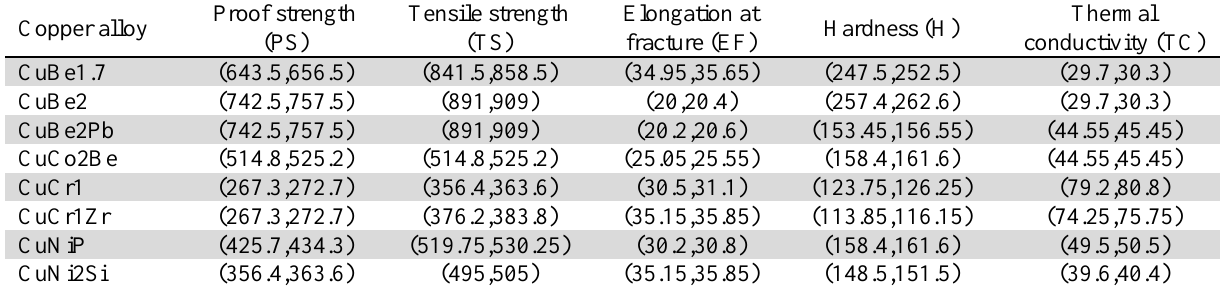
Grey decision matrix for copper alloys Copper alloy